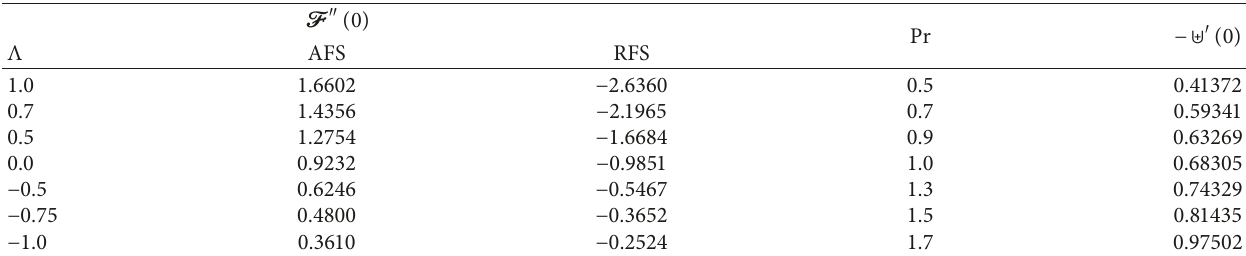
Figure 11: Dissimilarity of ⊎ ( η ) being some different values of Λ � 0 for only RFS. Table 1: Different values of skin friction coefficients and local Nusselt number for different values of Λ and Pr.